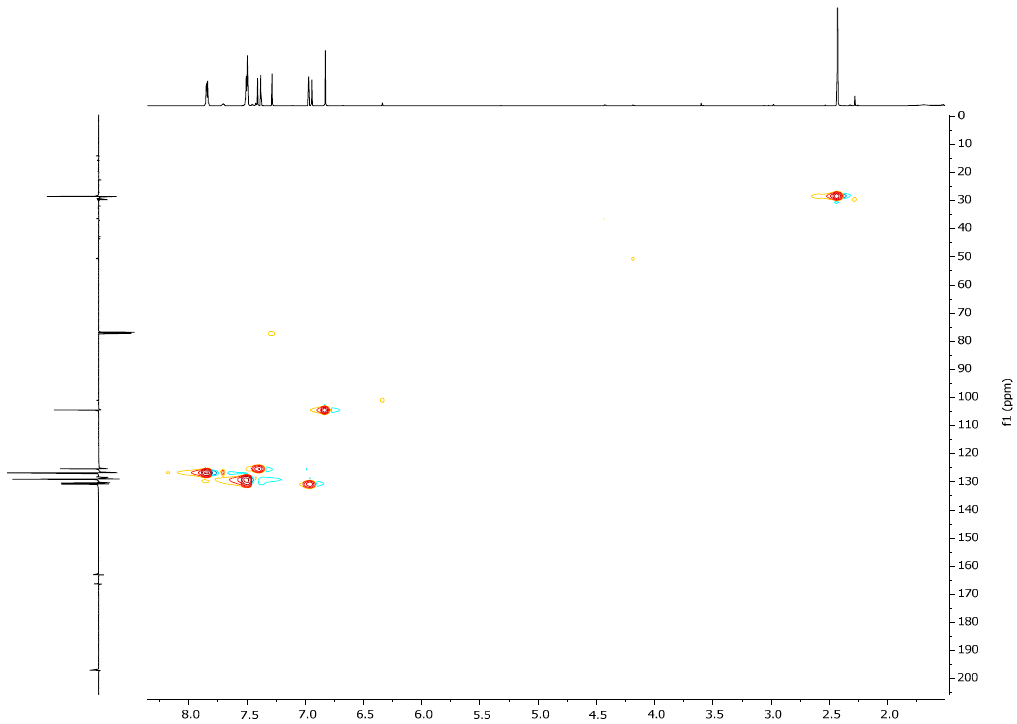
Figure 3. Data of 1 H- 13 C heteronuclear single-quantum correlation spectroscopy for compound (E)- 4c (CDCl 3 ).